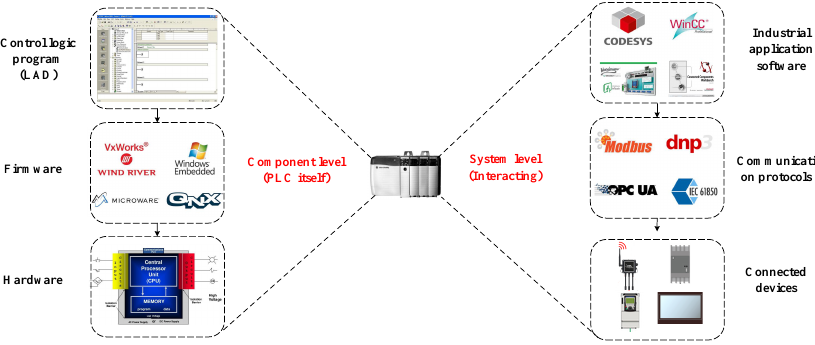
Figure 3. Component-level and System-level